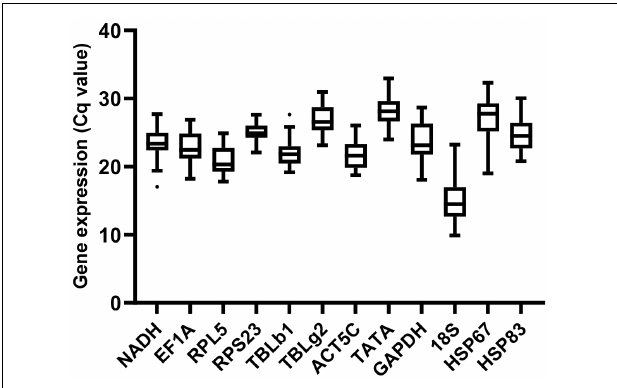
FIGURE 1 | Expression profiles of reference genes in all 36 samples in M. pharaonis. The expression level of reference genes is presented with Cq value. The dots indicate outliers.